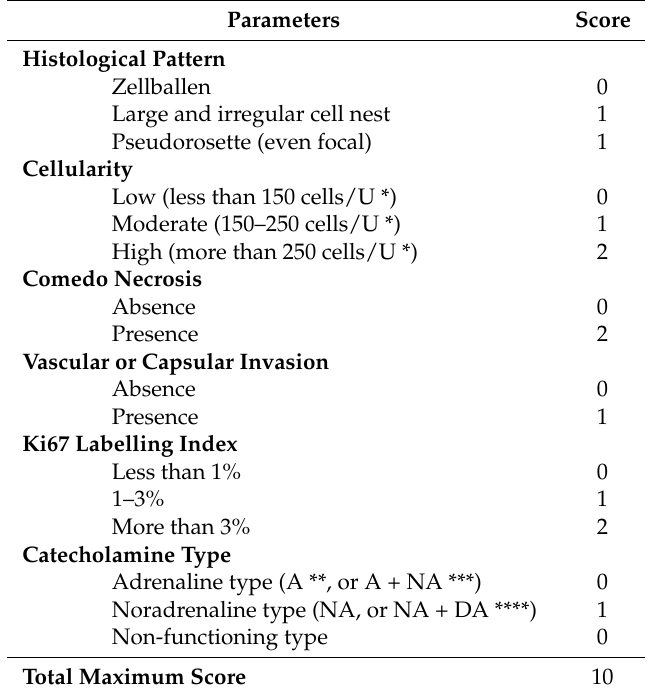
Table 1. Parameters and score in grading of adrenal pheochromocytoma and paraganglioma (GAPP).